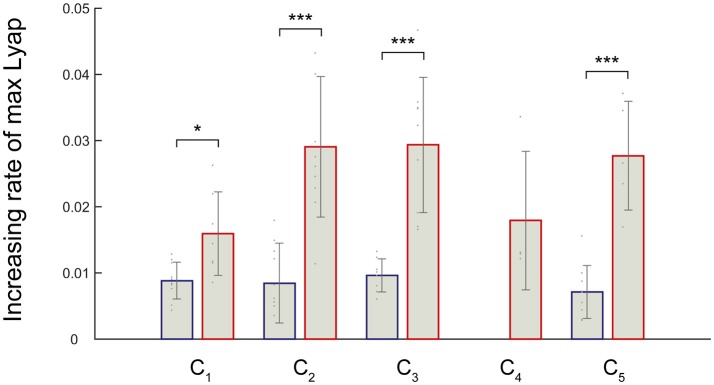
Increasing rate of the maximum Lyapunov exponents in response to the activation of a muscle synergy. Blue bars denote the average increasing rate of the maximum Lyapunov exponents at slower walking speeds (2.0–5.0 km/h). Red bars represent average the increasing rate of the maximum Lyapunov exponents during faster walking speeds (5.0–8.0 km/h). Error bars denote standard deviations among subjects. Significance levels are illustrated as asterisks (*p < 0.05, ***p < 0.01).